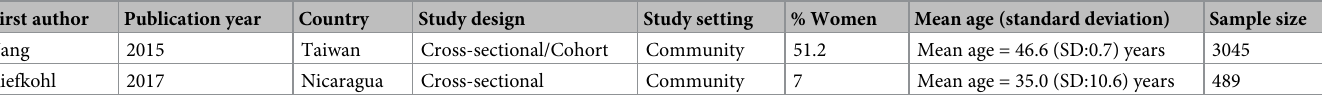
Table 1. Main characteristics of selected